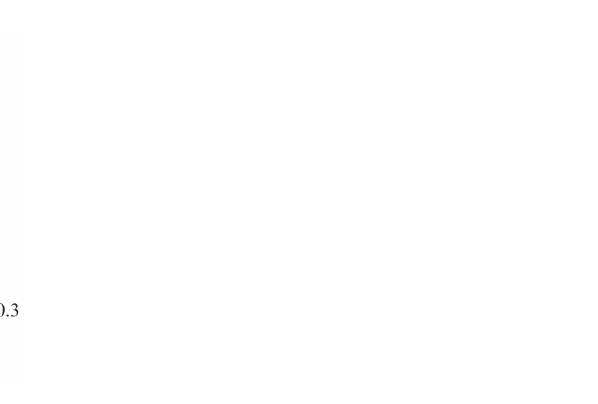
Figure 2. Stress component T 11 with a spatial resolution of x ∈ [ 0 : 0.001 : 0.3 ] , y ∈ [ 0 : 0.001 : 15 ] .